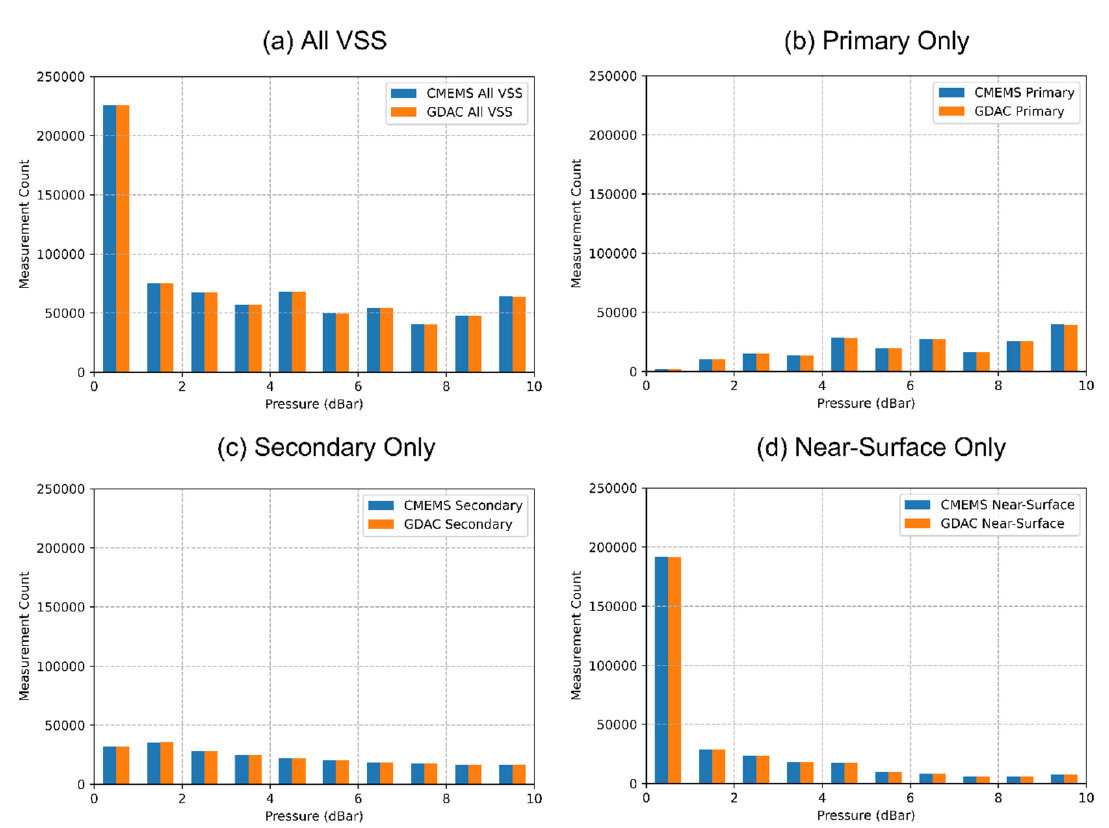
Figure 9. Distribution of Nobs from the two data sets against pressure: ( a ) measurements from all VSSs are included, ( b ) primary VSS only, ( c ) secondary VSS only, and ( d ) near-surface VSS only.